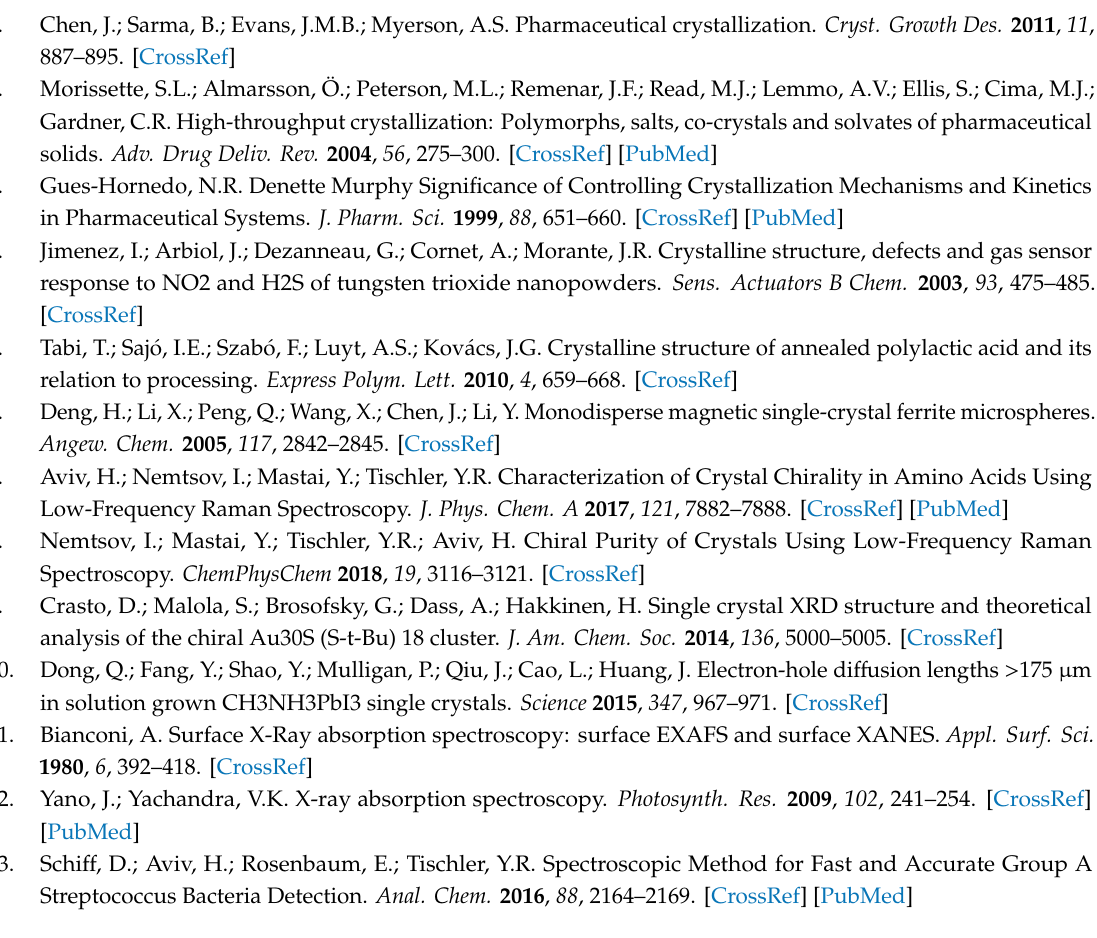
Figure S1: Regular Raman spectra from the (101) plane of the L-Ala crystal excited at di ff erent beam polarization directions; Figure S2: Regular Raman spectra from the (002) plane of the L-Ala crystal excited at di ff erent beam polarization directions; Figure S3: Regular Raman spectra from the (011) plane of the L-Ala crystal excited at di ff erent beam polarization